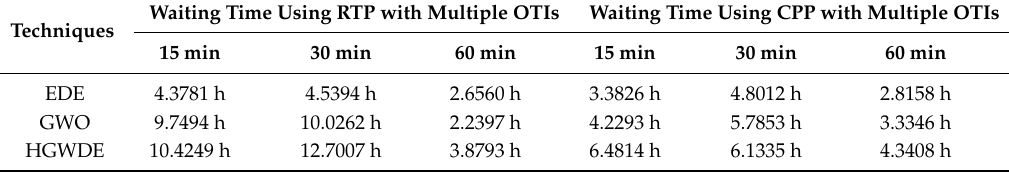
Table 9. Waiting time comparison of different techniques for 24